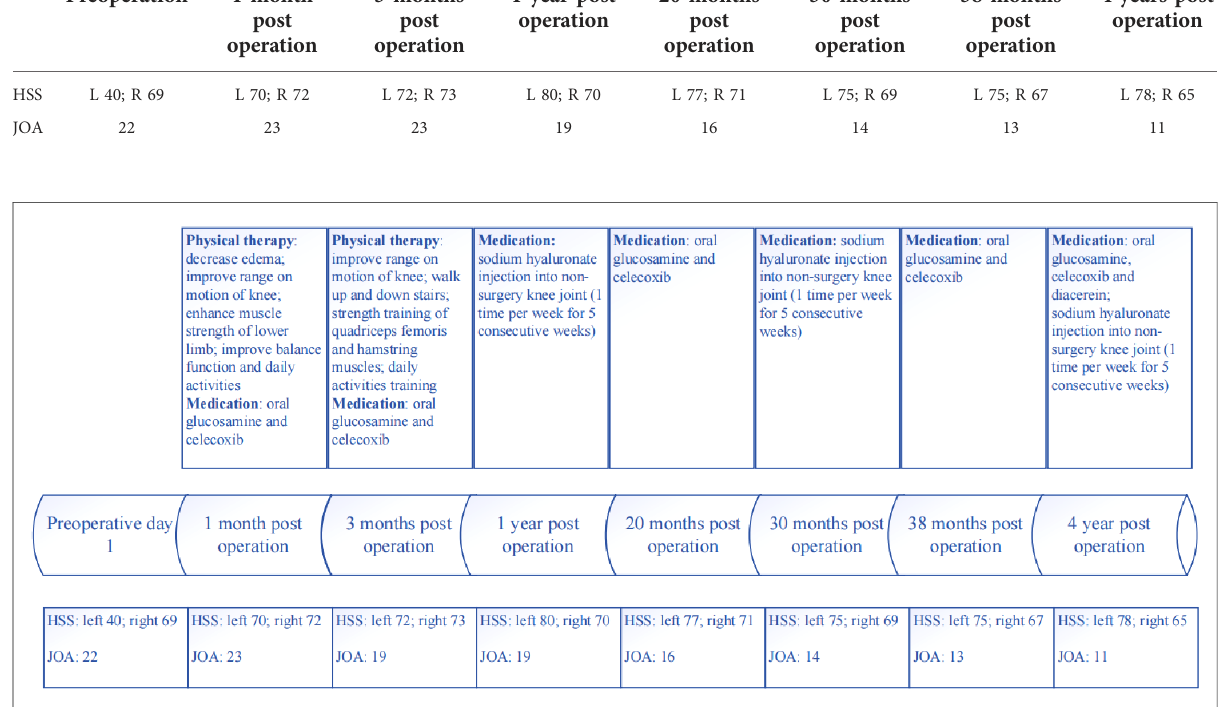
TABLE 1 Changes in HSS score and JOA score.